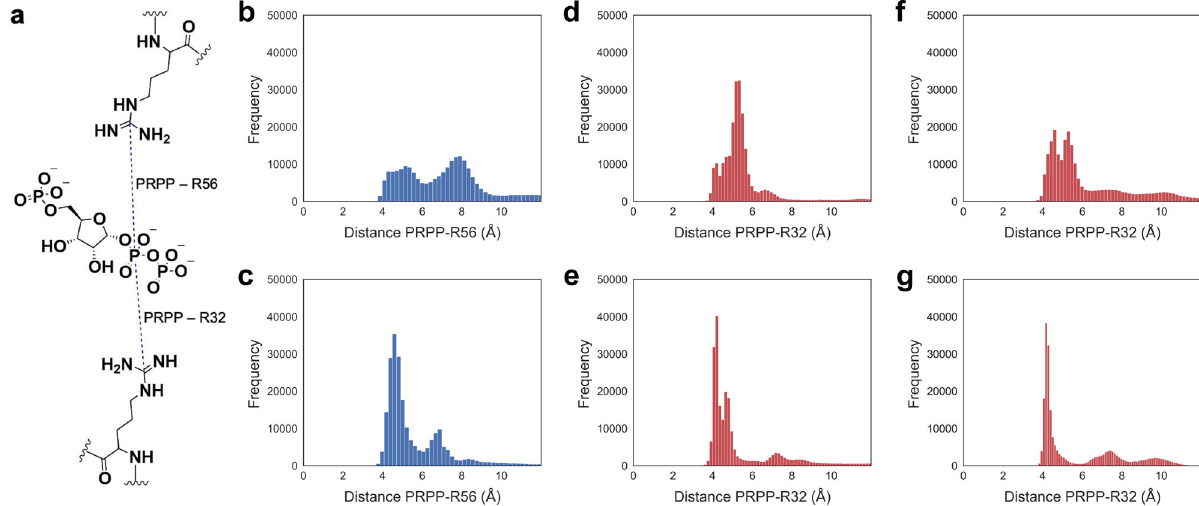
Fig. 6 | Effect of Pa HisZbinding on Pa HisG S R56 and R32 rotamers.a Schematic renderingofthedistances(dashedlines)betweenC ζ ofeitherR56orR32andP α of thePP i moietyofPRPPmonitoredduringMDsimulations,henceforthreferredtoas PRPP – R56distanceandPRPP – R32distance,respectively. b DistributionofPRPP –